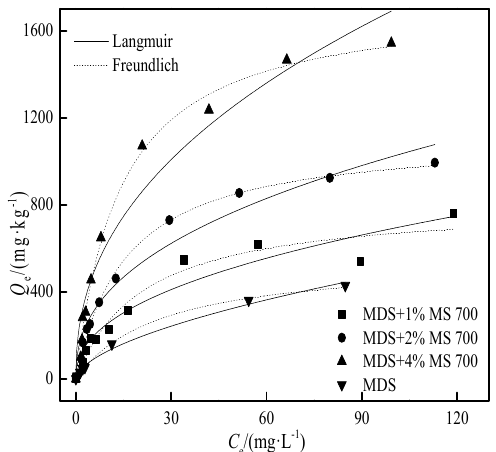
Figure 7. The effect of the weight ratio of MS700 on the Cd adsorption in a mixed system.